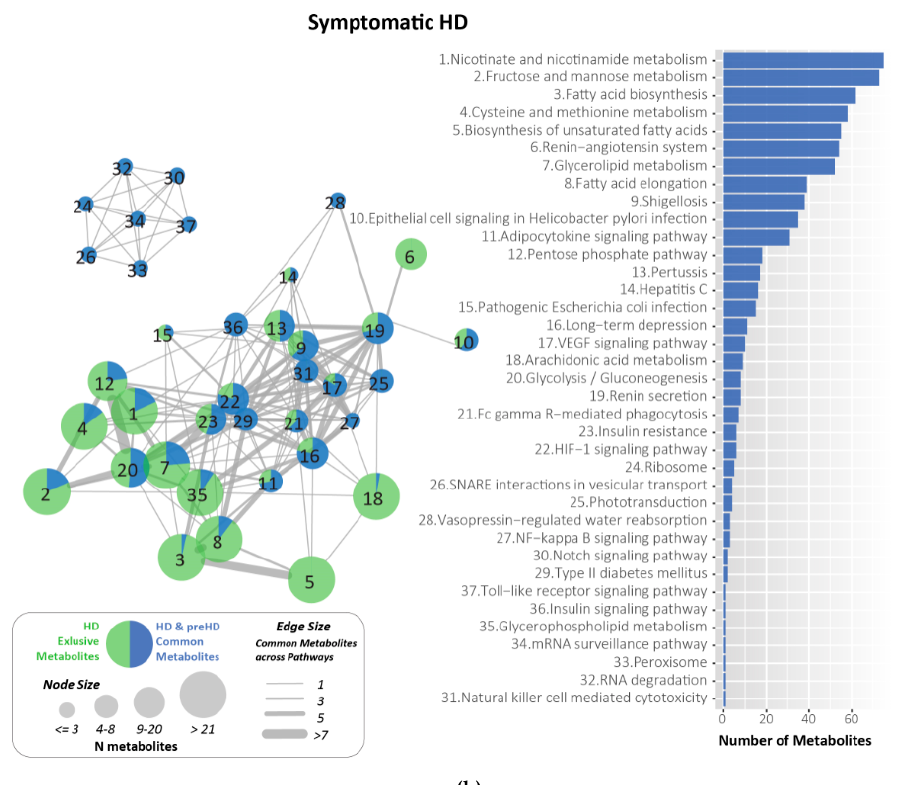
Figure 6. Pathway-metabolite network with pathways and the common and exclusive metabolites for pre-symptomatic and symptomatic HD ( a ) Pathways and common and exclusive metabolites for pre- symptomatic HD ( b ) Pathways and exclusive metabolites for symptomatic HD. The top pathways are shown in colour. Green nodes represent the number of exclusive metabolites for either the pre- symptomatic or symptomatic HD stage. Blue nodes represent the common metabolites in both HD stages. The node size represents the number of common metabolites and smaller nodes represent; the smaller the number of metabolites and larger nodes, the greater the number of metabolites. Edge width represents the number of common metabolites across the pathways.